Question: Describe this figure in one sentence.
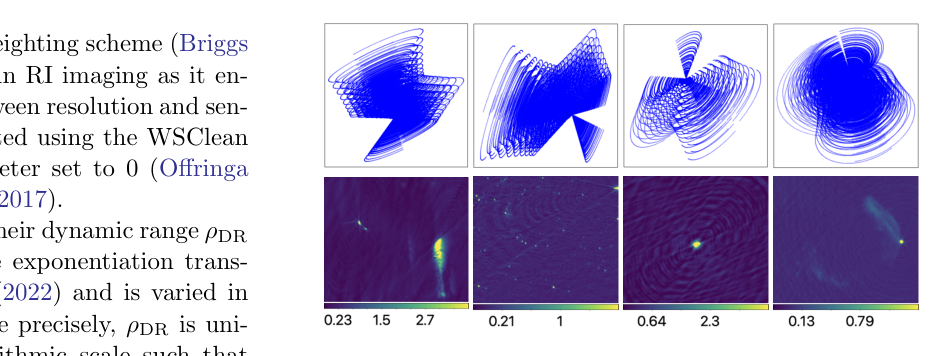
Answer: A selection of simulated 2D Fourier sampling patterns with the antenna configuration of the VLA (top row) and resulting dirty images (linear scale; bottom row). The depicted dirty images correspond to the ground-truth images shown in Figure 3.